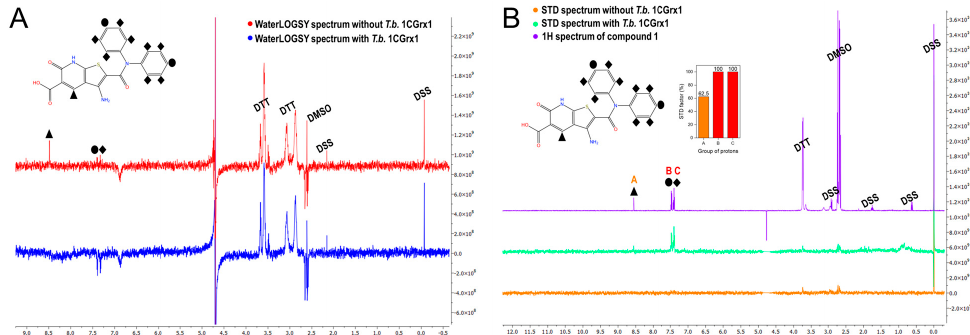
Figure 3. Experimental confirmation of compound 1 binding to T.b. 1CGrx1 by ligand-based NMR techniques. ( A ) WaterLOGSY spectra of compound 1 (100 µM) in the presence (blue) and in the absence (red) of T.b. 1CGrx1 (5 µM). The assignment of the signals is reported on the 2D structure of the molecule. ( B ) STD spectra of compound 1 (100 µM) in the presence (turquoise- green) and in the absence (orange) of T.b. 1CGrx1 (5 µM), and 1H NMR spectrum of compound 1 (100 µM) in 50 mM sodium phosphate, pH 7.1, 150 mM NaCl, 2 mM DTT, and 0.04% (w/v) NaN3, and STD binding epitope mapping of compound 1. The STD factor (%) for each group of protons